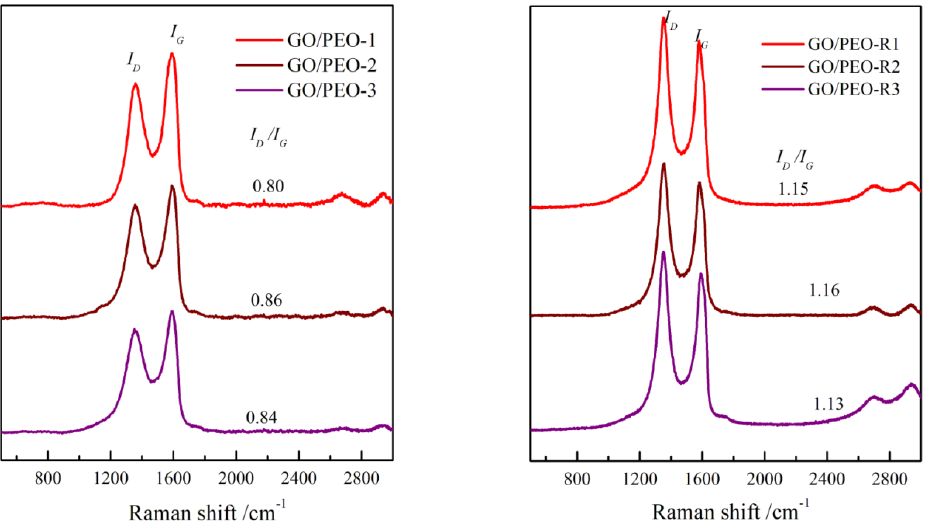
Figure 5. Raman spectra of the films.